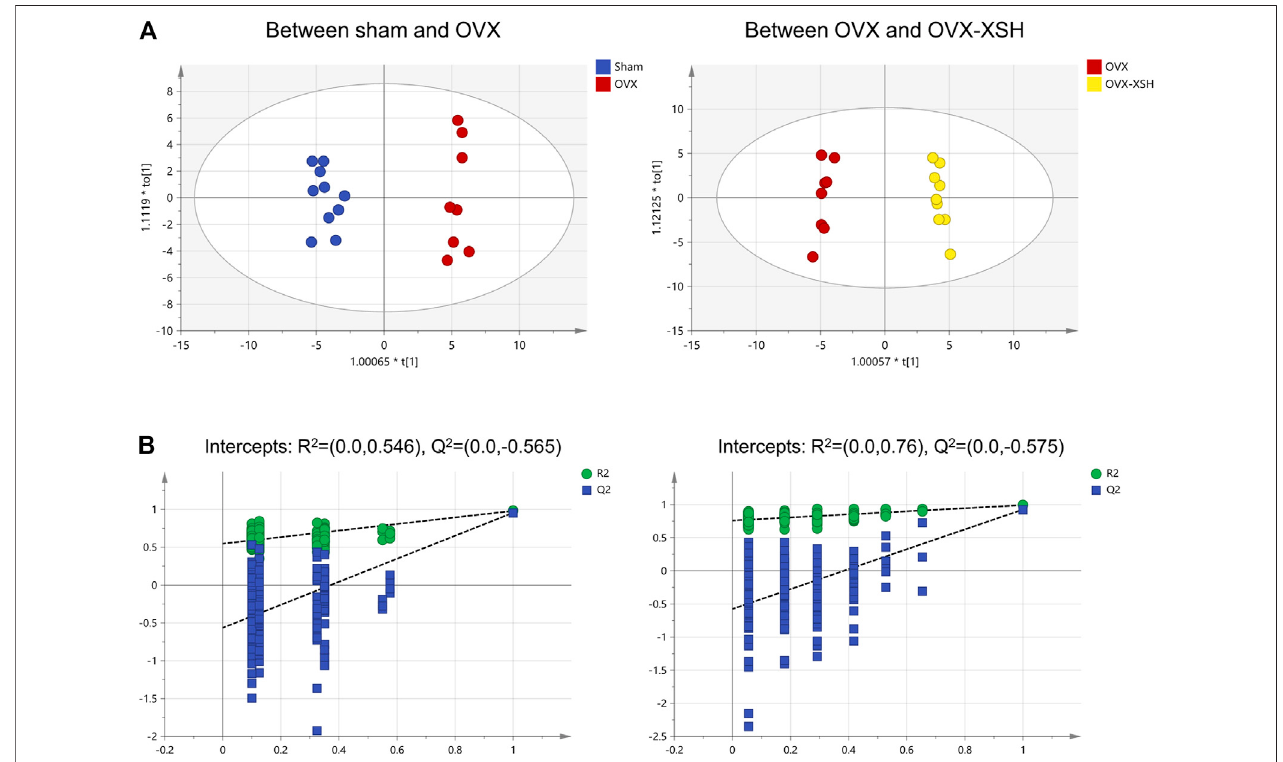
FIGURE 8 | Multivariate statistical analysis of metabolic characters of plasma samples acquired by GC-MS. (A) Score plot of OPLS-DA between different animal groups. (B) Results of cross-validation between different animal groups. n (cid:2) 8 – 10 per group.